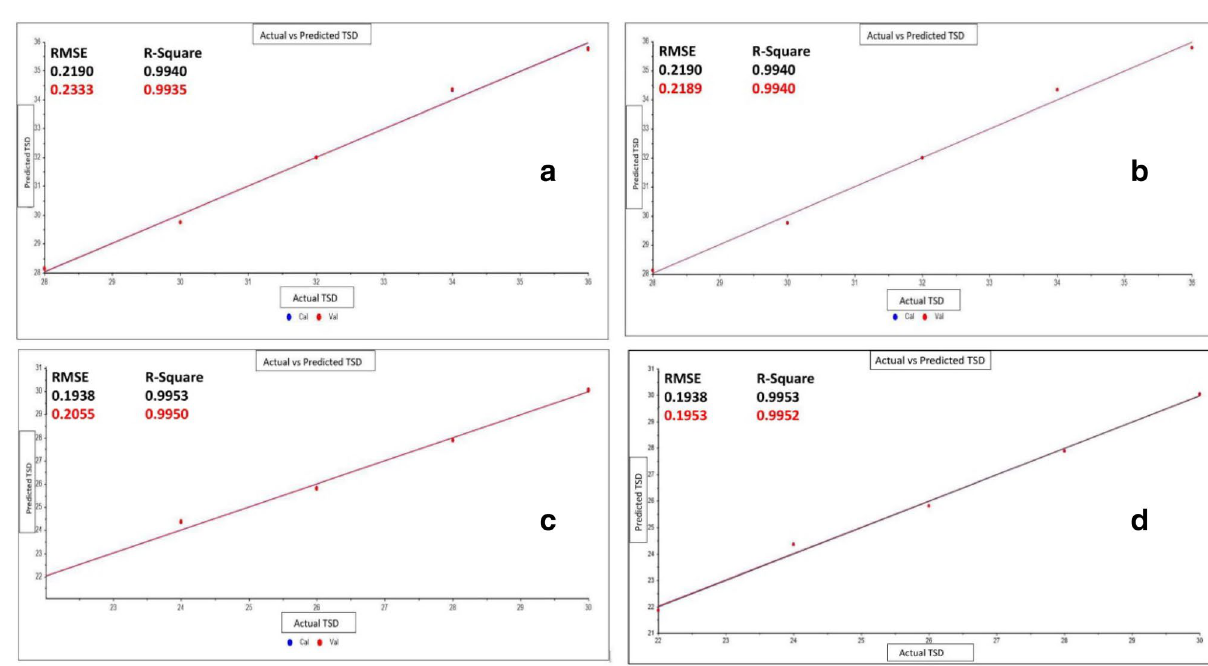
Figure 5. PLSR plots of ( a ) actual vs cross validated prediction of TSD for semen (100%), ( b ) actual vs externally validated prediction of TSD for semen (100%), ( c ) actual vs cross validated prediction of TSD for urine (100%), ( d ) actual vs externally validated prediction of TSD for urine